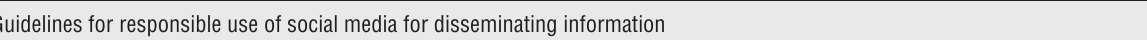
Table 1 - Criteria for the responsible use of the information disseminated on social media. Modified from Chan et al. (6). Guidelines for responsible use of social media for disseminating